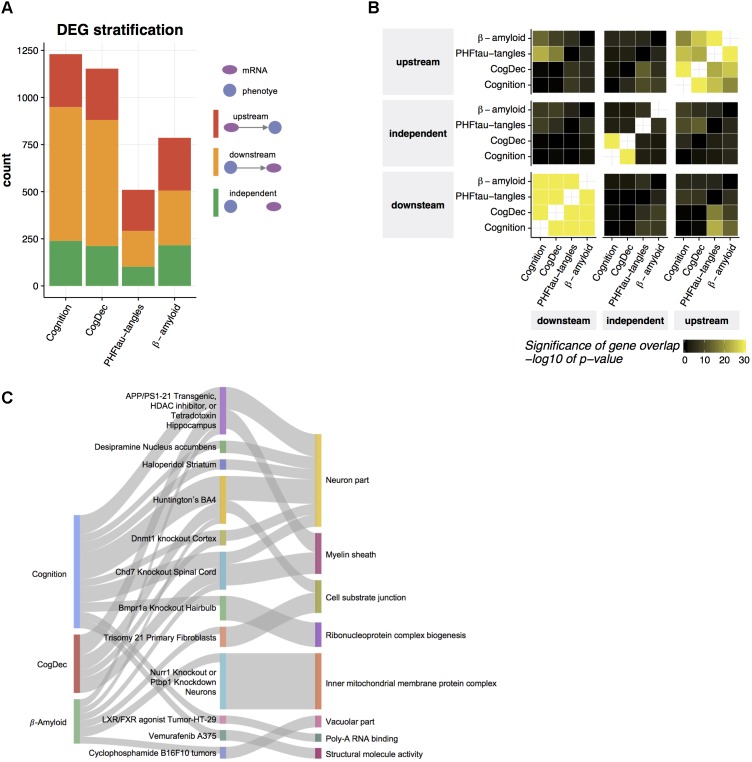
Prediction of upstream genes for neuropathologies and cognitive measures. (A) Predicted relationships of DEGs to neuropathologies and cognitive measures. An LRN was built for each DEG and for each neuropathology or cognitive measure, and then genes were classified as upstream, independent, or downstream of a given phenotype, based on the direction of the edge between the mRNA node and the phenotype node. (B) Common upstream and downstream genes across phenotypes. Pairwise overlaps among genes predicted as upstream, independent, and downstream of each phenotype were evaluated by hypergeometric test. (C) Gene set enrichment for upstream genes. The enrichment of gene signatures from public RNA-seq studies with upstream genes was assessed by hypergeometric test. The top 10 gene signatures significantly associated with the genes upstream of phenotype (FDR < 0.05) were depicted in the middle layer. Gene signatures from the same tissue or cell type were displayed as one category. The thickness of edge corresponds to the fold enrichment. Gene signatures for public RNA-seq studies were further annotated based on their enrichment of gene ontology (GO) terms. If a gene signature was significantly enriched with a given GO term (Bonferroni corrected p-value < 0.05) and the overlapped genes contain at least one of upstream genes, an edge between the study name and the most enriched GO term is depicted.